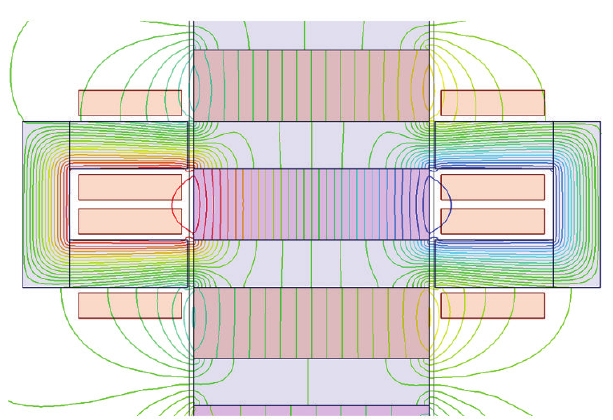
Figure 32: Magnetic flux at 𝑡 = 40 ms.